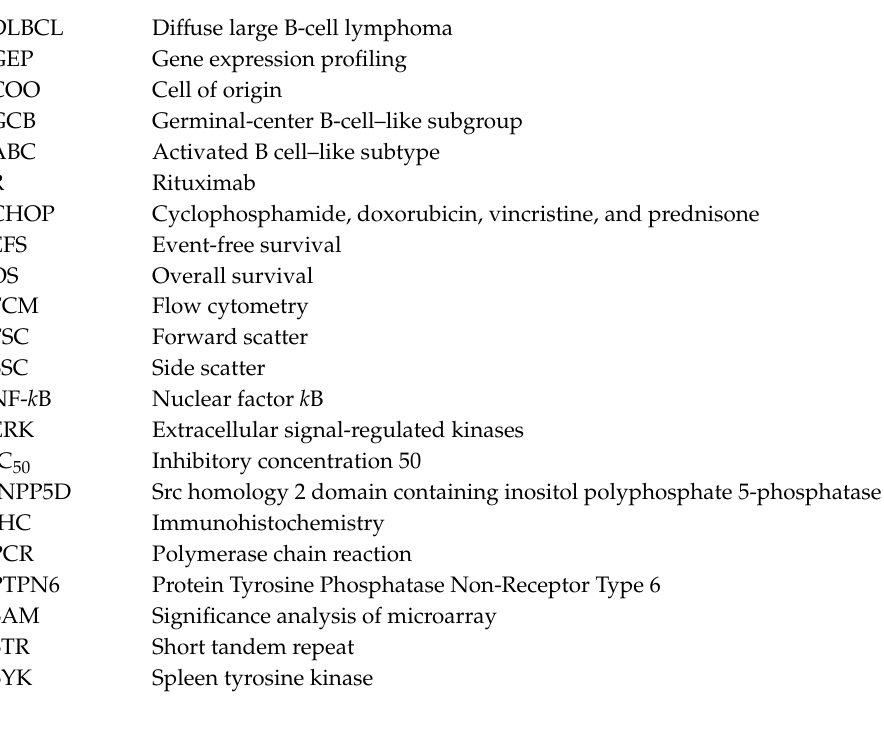
Figure S1: Principal component analysis representing MFI of FCM biomarkers used for DLBCL cell lines discrimination in our identification algorithm. Figure S2: Survival curves of patients with DLBCL in the CHOP Lenz cohort divided in two groups according to the expression of the prognostic lymphoid markers. Figure S3: Expression of prognostic markers in the ABC and GCB DLBCL samples from the Lenz cohorts ( n = 350). Figure S4: CD10, BCL2, BCL6, CD103, LAIR1, CD81 and CD11c expression in GCB and ABC DLBCL-derived cell lines. Figure S5: Comparison of CD10, CD81, CD39 and CD103 gene expression in DLBCL samples and normal centrocytes and centroblasts (GSE12195 dataset). Figure S6: Correlation between gene expression of the prognostic lymphoid markers (A ff ymetrix microarrays) and their protein expression in 16 DLBCL cell lines by MFC. Figure S7: E ff ect of the combination of etoposide (increasing concentrations) and the BCL6 inhibitor 79-6 in DLBCL-derived cell lines. Table S1: Antibodies references. Table S2: Mean fluorescence intensity of 27 lymphoid markers in 16 DLBCL-derived cell lines obtained by multiparameter flow